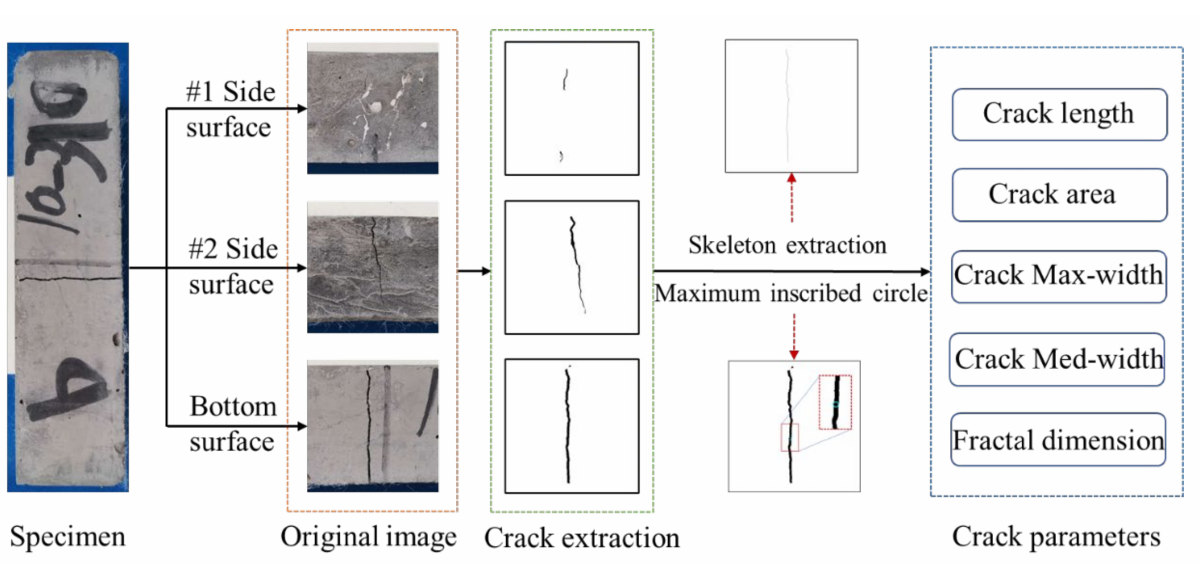
Figure 3. Crack parameters extraction